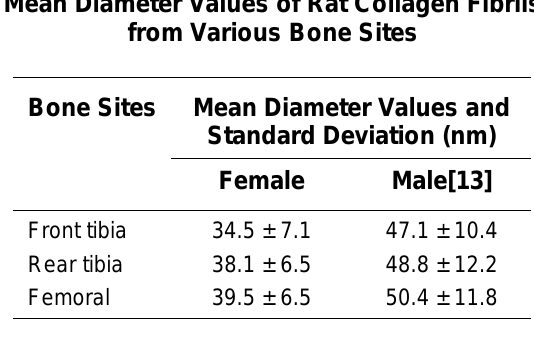
Mean Diameter Values of Rat Collagen Fibrils from Various Bone